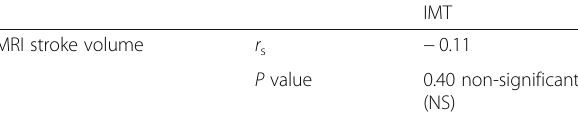
Table 9 Correlation between stroke volume and IMT on the symptomatic side and on the asymptomatic